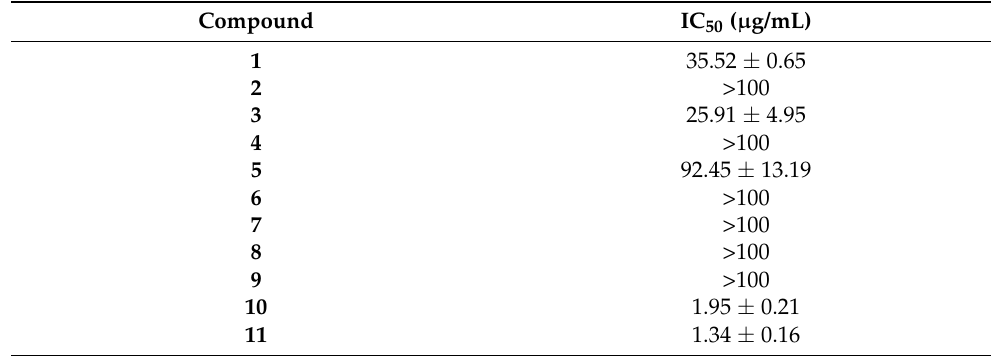
Table 3. Antioxidant activity (expressed as IC 50 in µ g/mL) of compounds 1 – 11 isolated from the organic extract of the fresh needles of Pinus nigra subsp. nigra